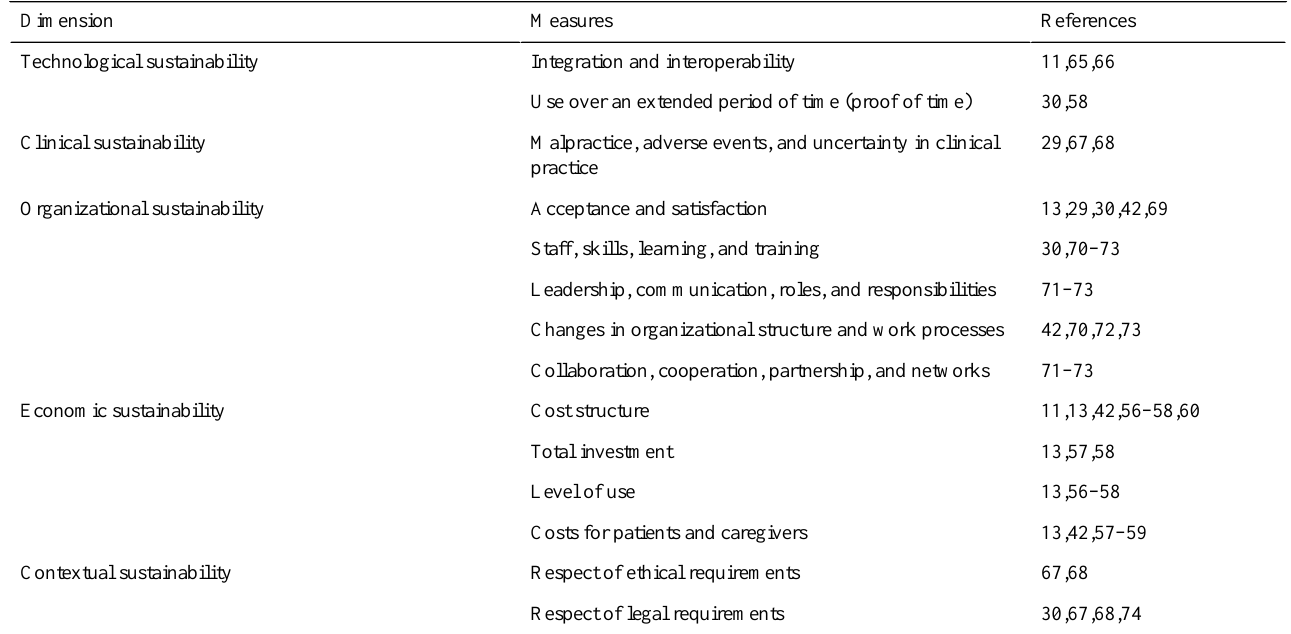
Table 2. Sustainability-related criteria